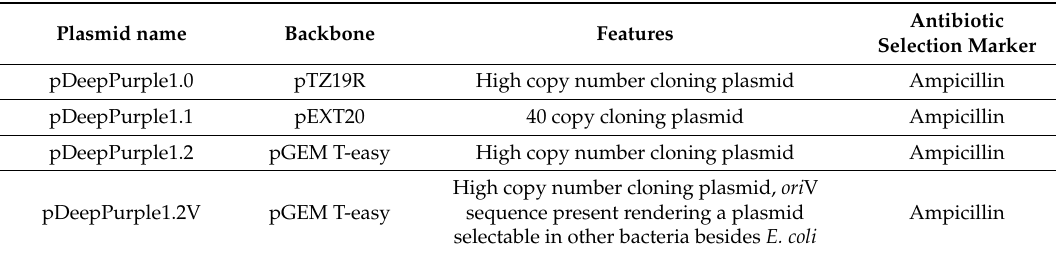
Table 1. Plasmids generated in this